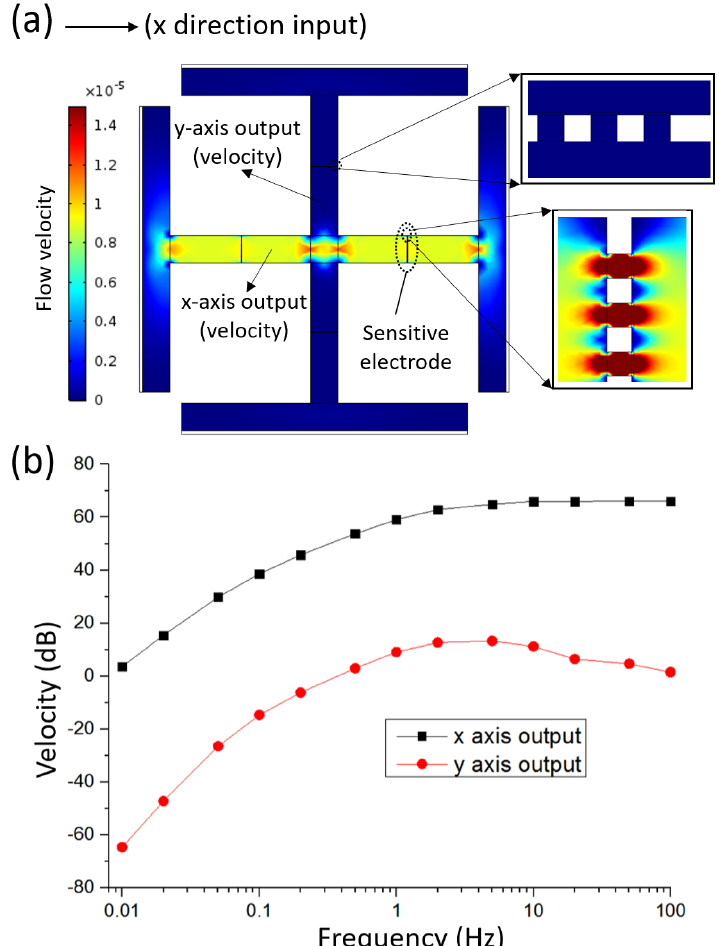
Figure 3. ( a ) Two-dimensional numerical simulation of the MEMS based integrated triaxial electrochemical seismometer in response to the x-direction vibration. ( b ) The simulation results of the MEMS based integrated triaxial electrochemical seismometer where multi-frequency velocities in the x-direction were inputting parameters and velocities on the x and y axes were outputting parameters.